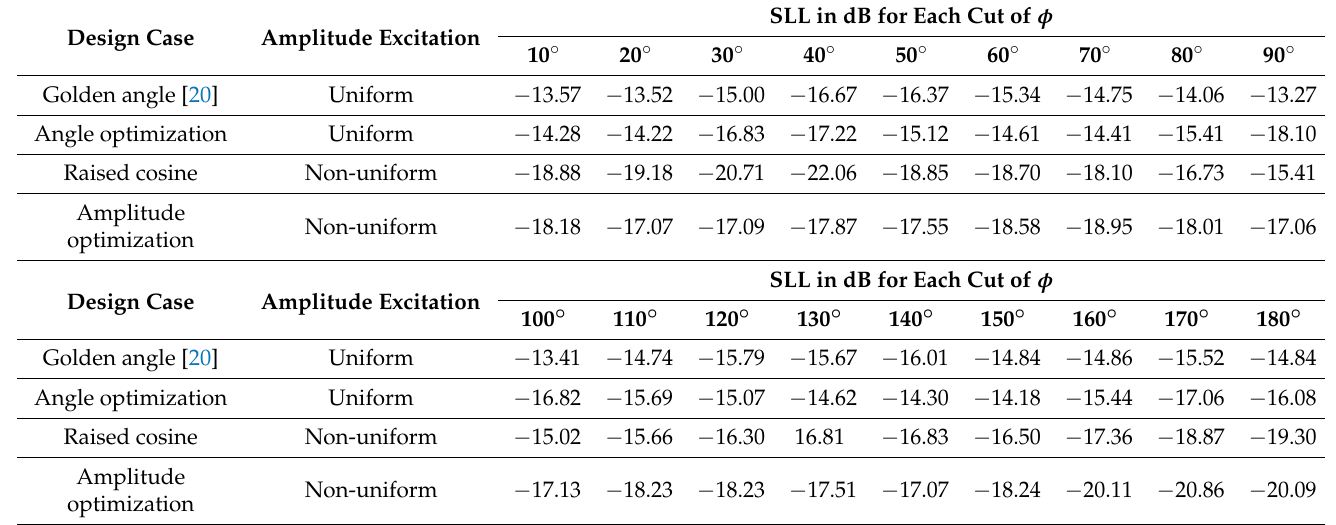
Table 1. A comparative analysis of the proposed techniques, with respect to the previous work published in [20], for the Fermat spiral array for maximum SLL reduction (array factor results).